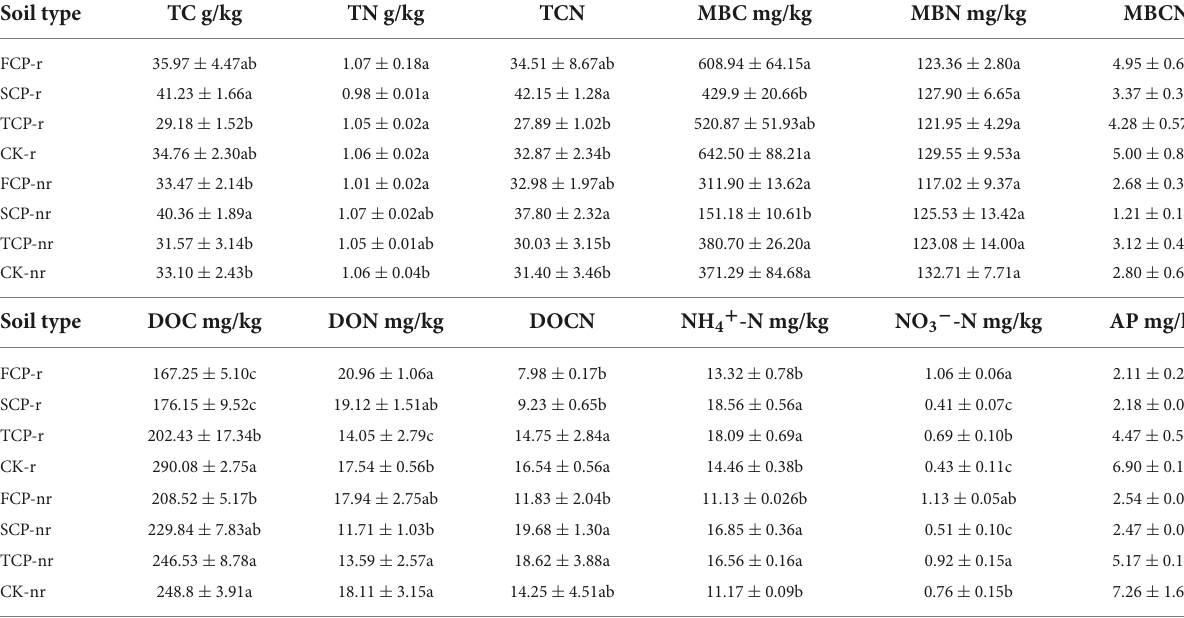
TABLE 1 Soil abiotic properties in Chinese fir seedings with different successive planting generations (rhizosphere and bulk soil).